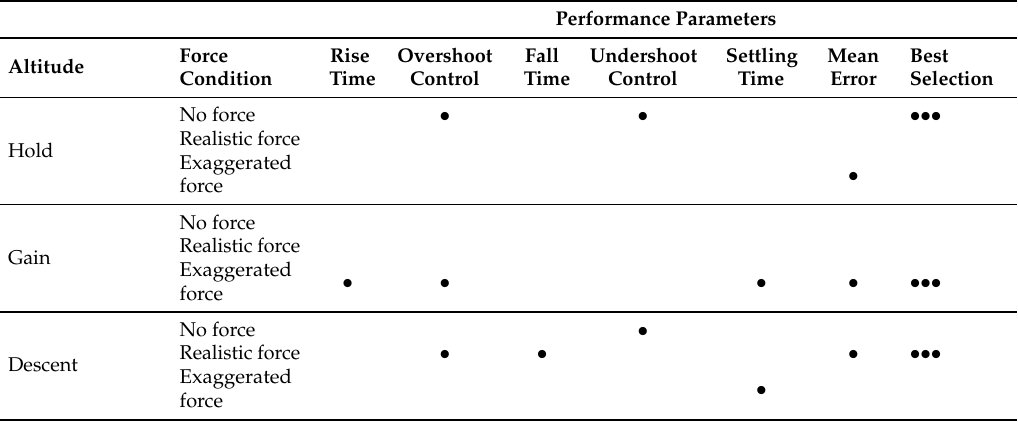
Table 10. Best force condition on the basis of performance parameters.